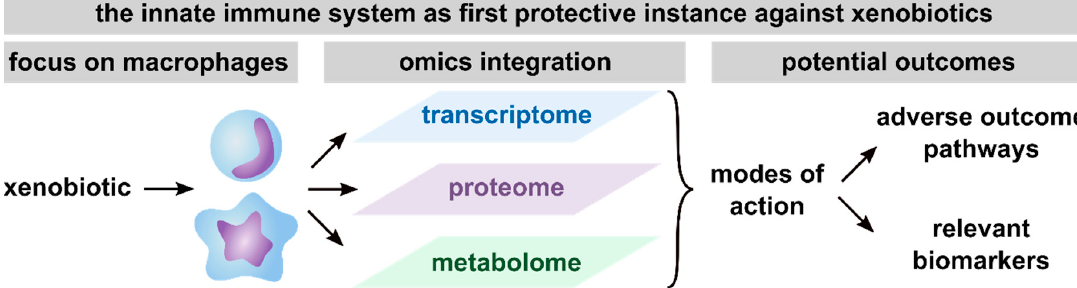
Figure 3. Summary of potential outcomes of multi-omics studies with a focus on macrophages. Presented are the outcomes that are achievable with the integration of transcriptome, proteome, and metabolome, including unraveling modes of action (MoAs), thus facilitating the definition of adverse outcome pathways (AOPs) and the identification of relevant biomarkers from any of the investigated omics layers.